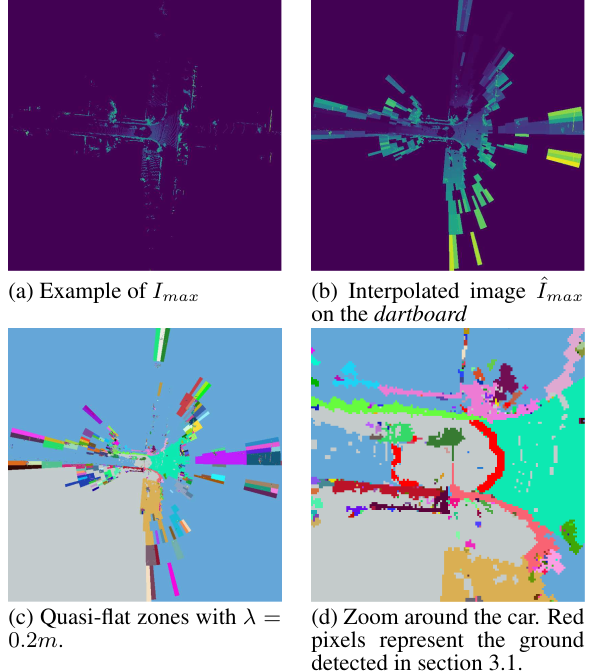
Figure 6. Example of analysis in interpolated image obtained on the frame 3721 in sequence 08 of SemanticKITTI